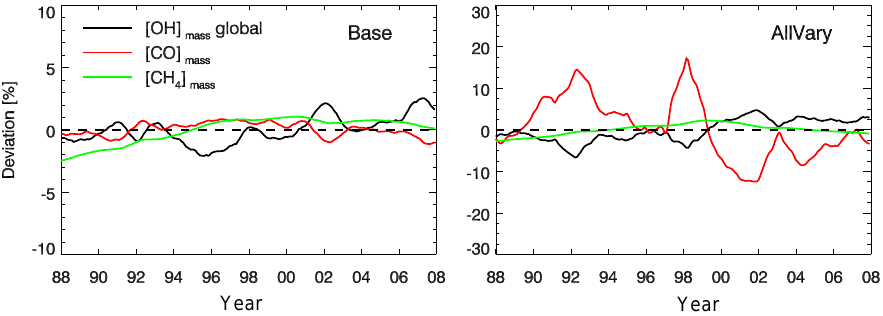
Figure 14. Deviations of tropospheric, mass-weighted OH, CO, and methane (12-month running mean) from the Base (left) and AllVary (right) scenarios. Note the different scales of the y axes.